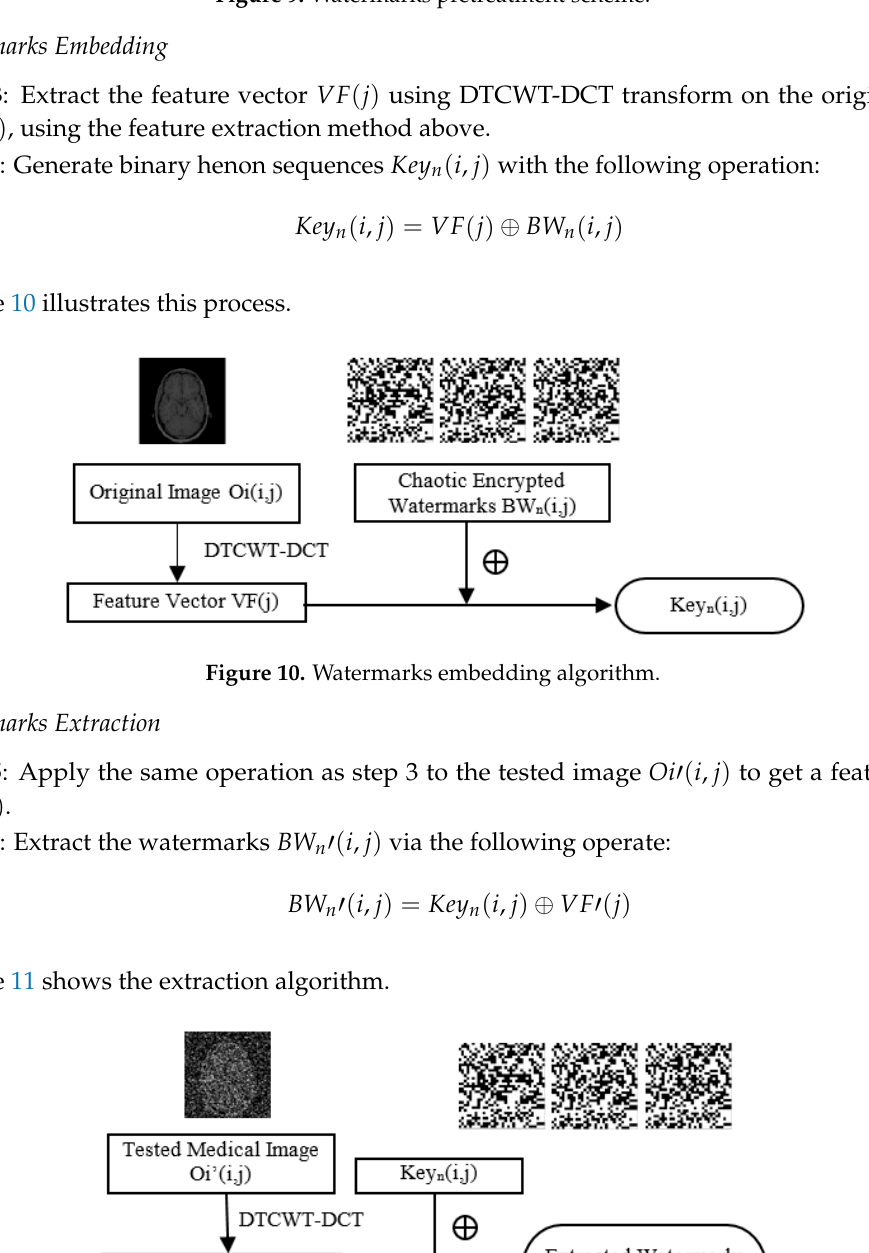
Figure 9. Watermarks pretreatment scheme.